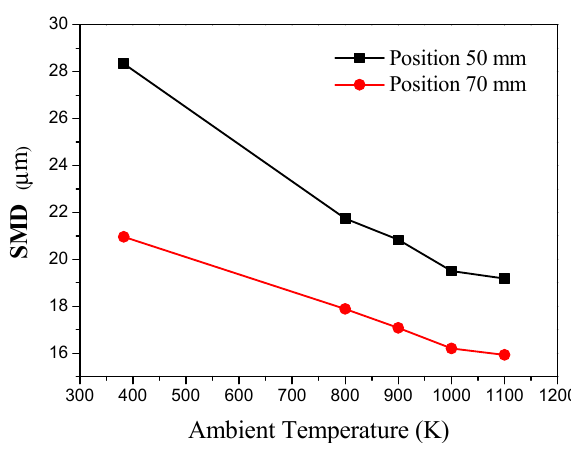
Figure 6. Effects of ambient temperature on SMD.